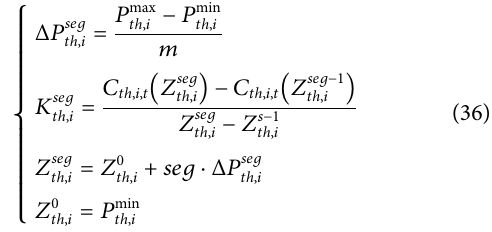
FIGURE 3 | Segmented linearization of operating costs of thermal power